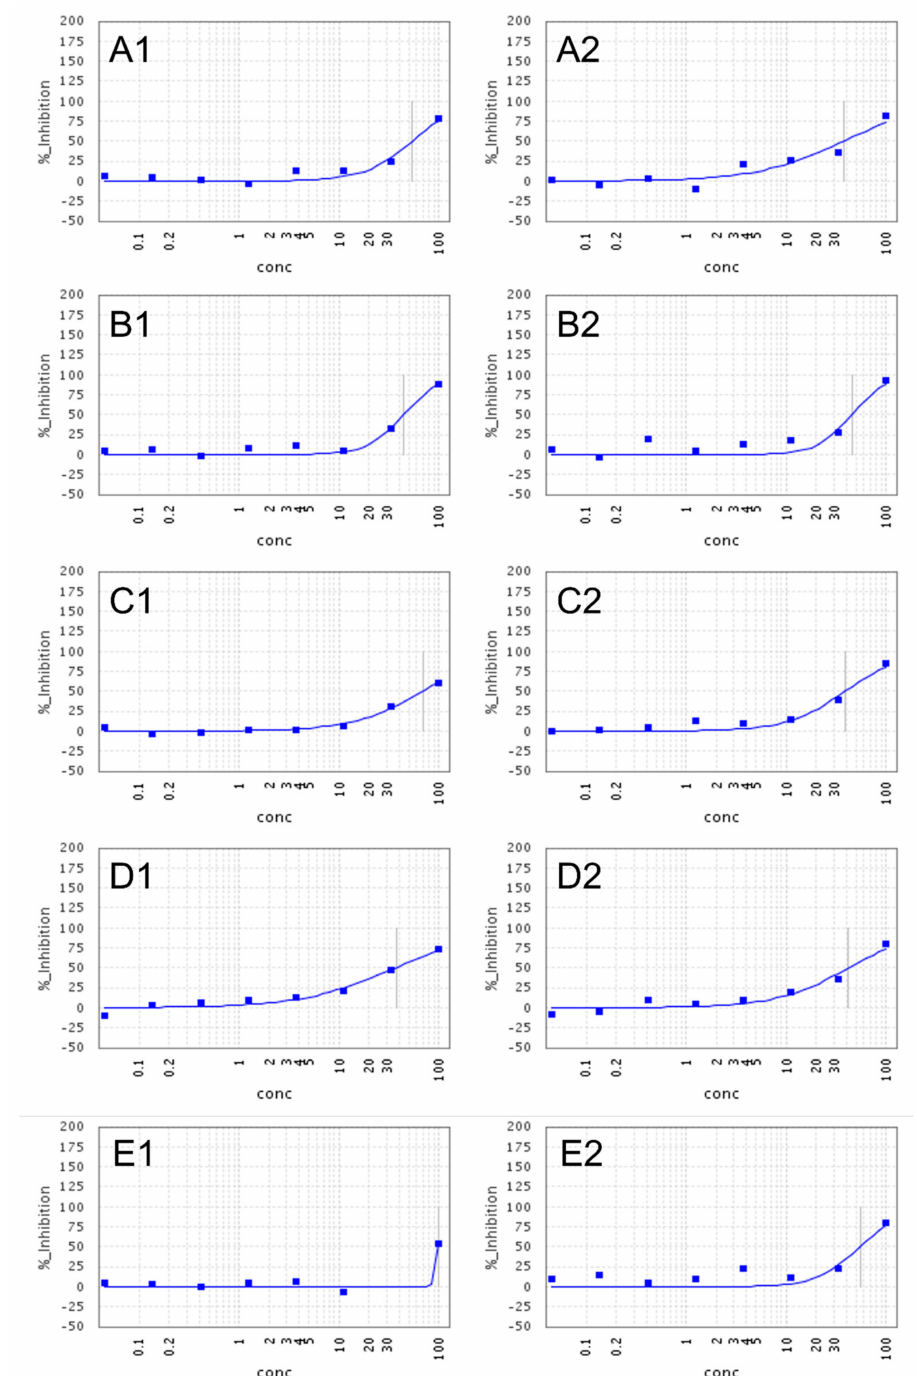
Figure 4. Dose-dependent inhibition SARS-CoV-2 replication of compounds 1 ( A ), 4 and 5 ( B ), 7 ( C ), 8 ( D ) and 11 ( E ). Each experiment was performed in duplicate; concentrations are in µ